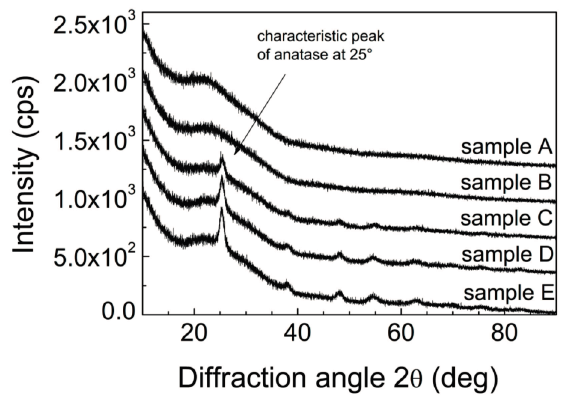
Figure 5. XRD patterns for samples